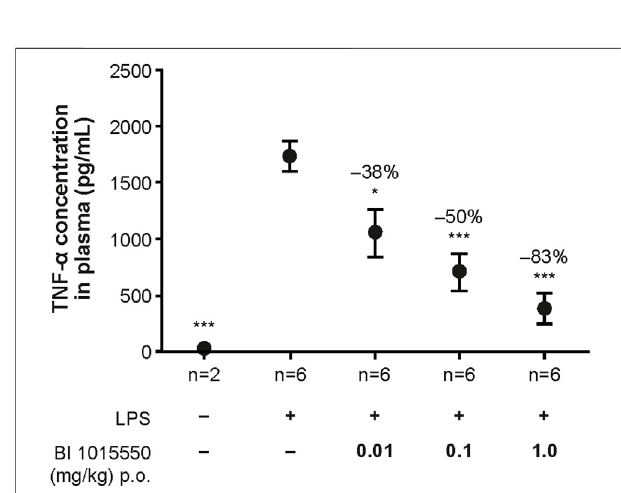
FIGURE3| InhibitionofLPS-stimulatedTNF- α releaseinwholeblood ex vivo in mice by BI 1015550. Mice were pre-treated with solvent or oral BI 1015550 at the doses indicated for 2 h before blood sampling, and then whole blood was stimulated with LPS for 4 h. Inhibition of TNF- α in % is given as negative number. Results are shown as means ± SEM from the number of animals indicated. *, p < 0.05; ***, p < 0.001. LPS, lipopolysaccharide; p.o., orally; SEM, standard error of the mean; TNF- α , tumor necrosis factor- α